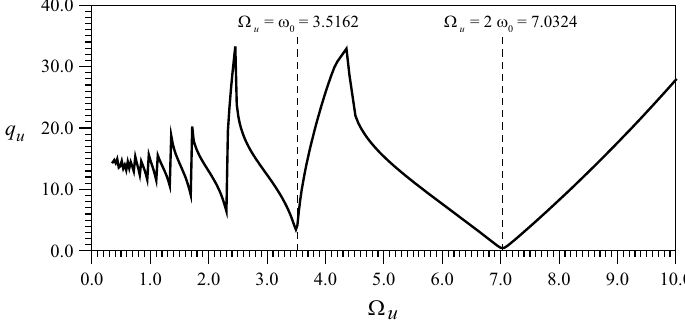
Fig. 3. Parametric instability boundary in the force control space. Axial load: q u cos(Ω u t ) .